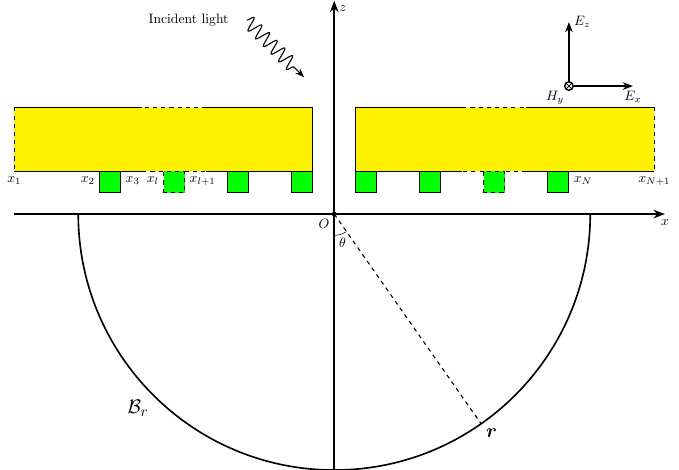
Figure 1. Schematic representation of a metal slit surrounded in the exit surface by dielectric gratings. A TM polarized plane wave impinges on the metal surface from